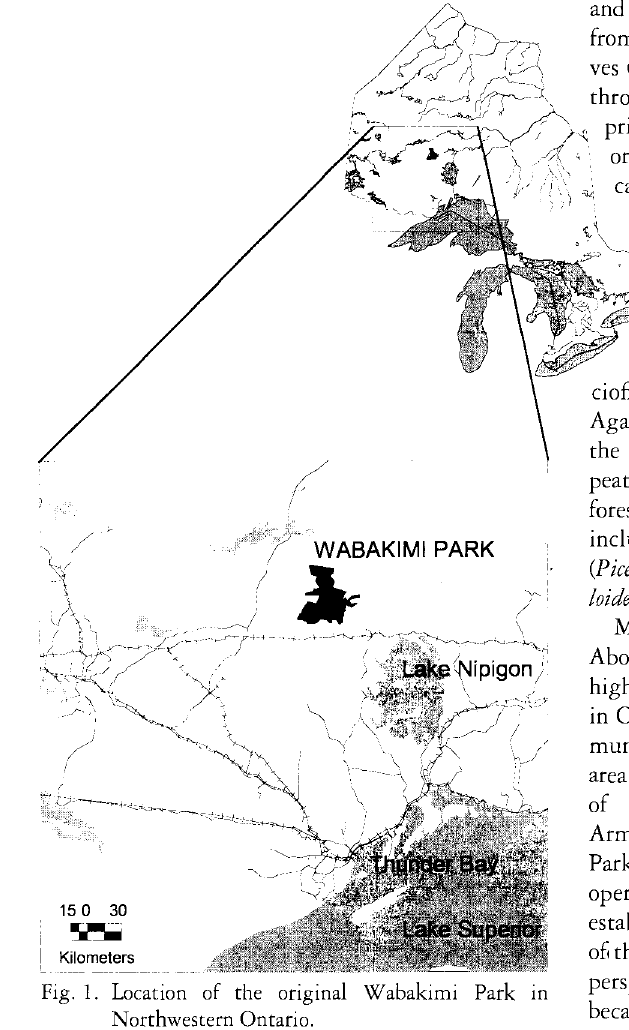
Fig. 1. Location of the original Wabakimi Park in Northwestern